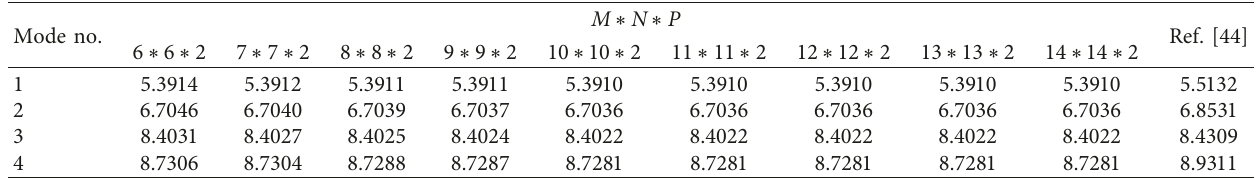
Table 2: Constringency study of frequency parameters Ω � ( ω b 2 / π 2 ) plates.